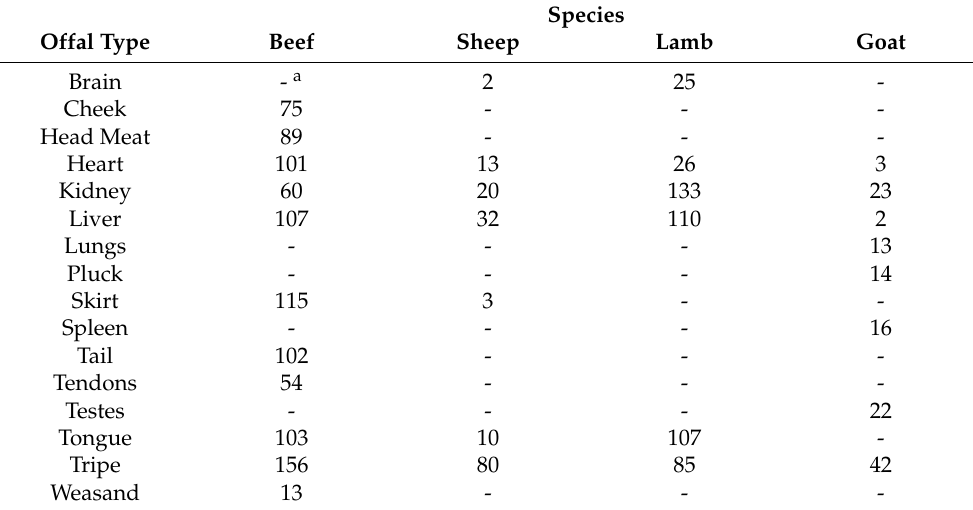
Table 1. Number of offal samples analysed for each